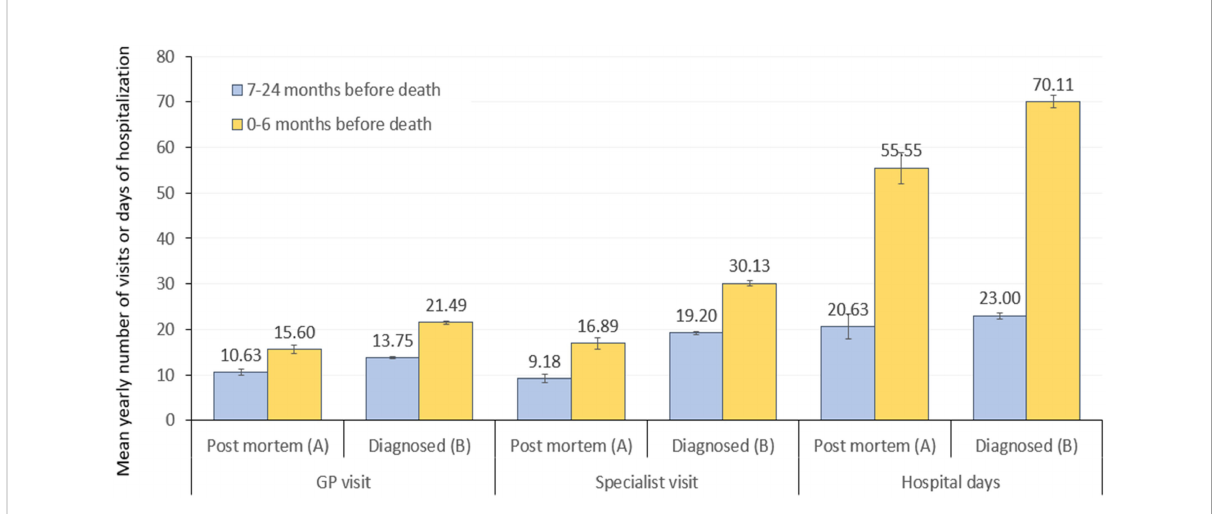
FIGURE 2 Mean annual number of GP visits, specialist visits, and hospital days within 7 – 24 months (blue) and 6 months (yellow) before the time of death among patients diagnosed with LC post-mortem (population A ) or during their lives (population B ). GP, general practitioner; LC, lung